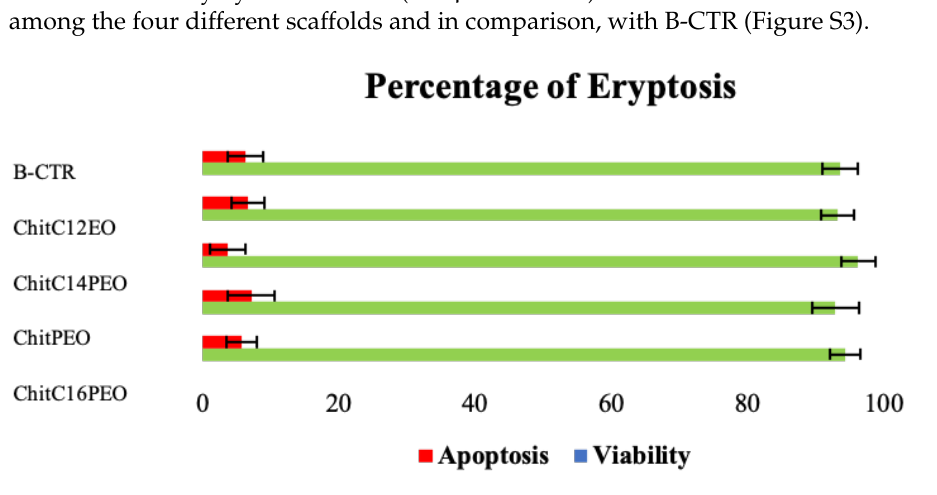
Figure 9. Percentage of eryptosis after 24 h of incubation with 4 electrospun scaffolds and without (B-CTR).